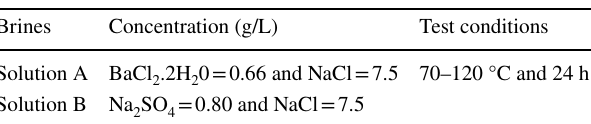
Table 1 Brine solution Brines Concentration (g/L) Test